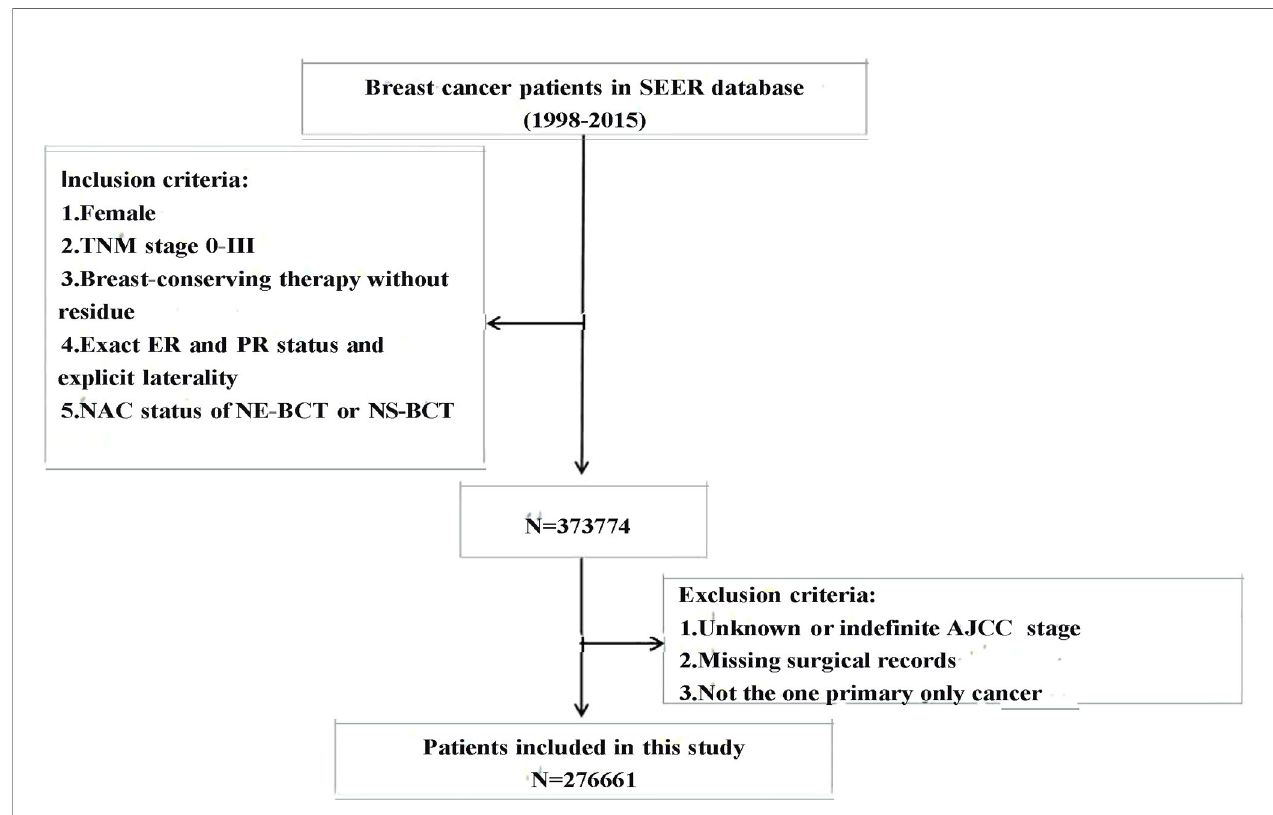
FIGURE 1 | Inclusion and exclusion criteria of the study